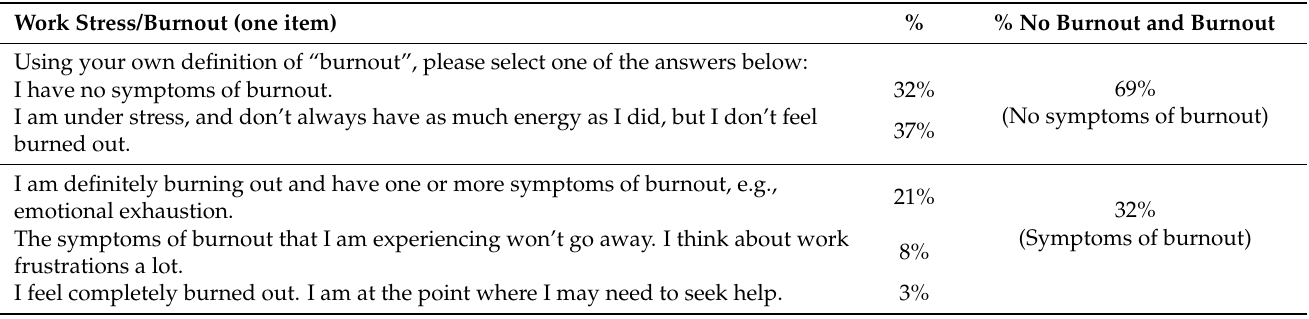
Table 6. Item analysis results: Work Stress/Burnout ( N =